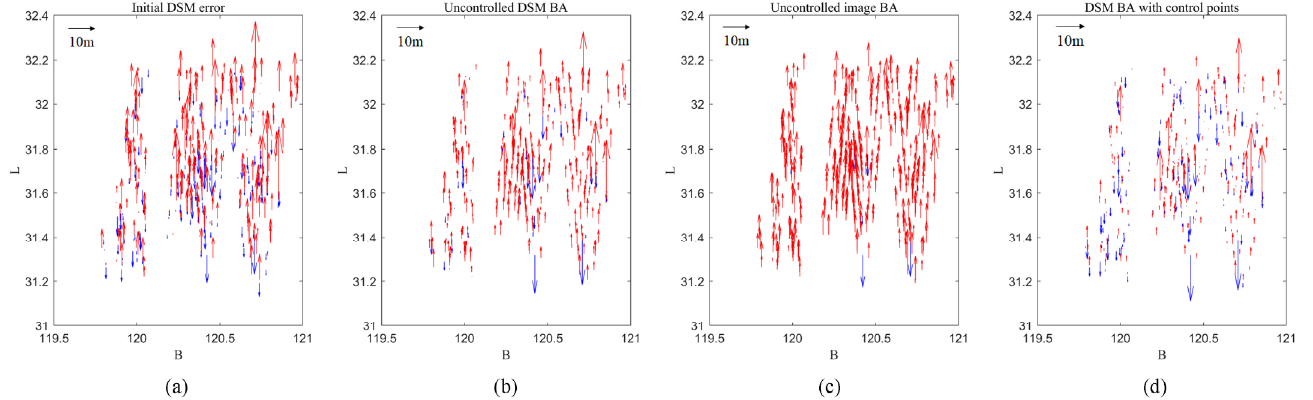
Figure 5. Elevation error distribution on check points for the ZY-3 DSMs (positive errors are indi- cated by the up-pointing red arrows and negative errors by down-pointing blue arrows). ( a ) before block adjustment, ( b ) uncontrolled DSM block adjustment, ( c ) uncontrolled images block adjust- ment. ( d ) controlled block adjustment.